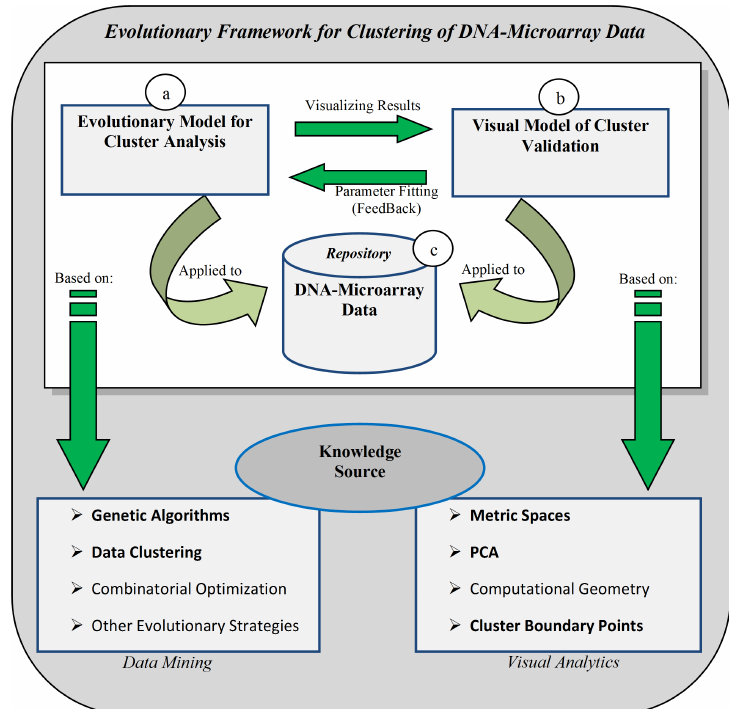
Figure 1: Evolutionary and visual framework for cluster analysis of DNA microarray data.